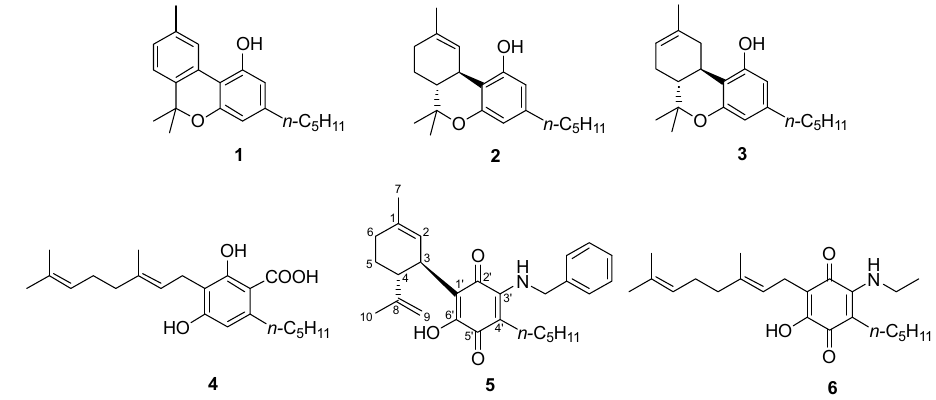
Figure 1. Structure of CBN ( 1 ), Δ 9 -THC ( 2 ), Δ 8 -THC ( 3 ), cannabigerolic acid (CBGA, 4 ), VCE-004.8 ( 5 ) and VCE 003.2 ( 6 ).